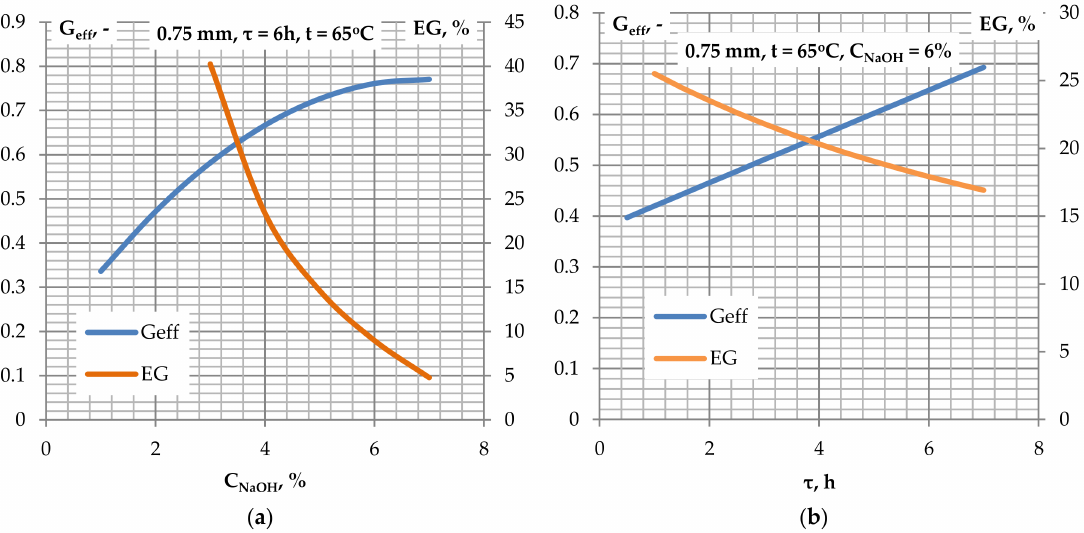
Figure 5. Effect of catalyst concentration ( a ) and pre-treatment time ( b ) on the glucose efficiency and relative glucose efficiency